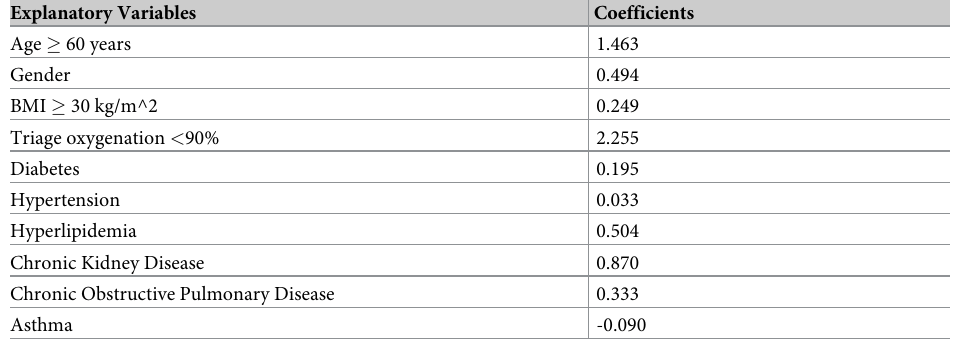
Table 5. Prediction tool: List of explanatory variables and coefficients computed using the development set (n = 6,000